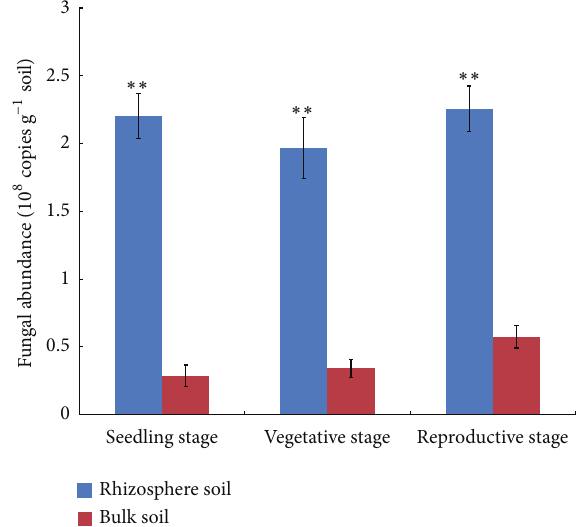
Figure 1: The abundance of fungi in the rhizosphere and bulk soil, as indicated by a real time PCR estimation of the copy number of an 18S rDNA fragment. Standard error bars calculated from three replicates. Significant differences based on Student’s 𝑡 -test indicated by asterisks ( ∗∗ 𝑃 < 0.01